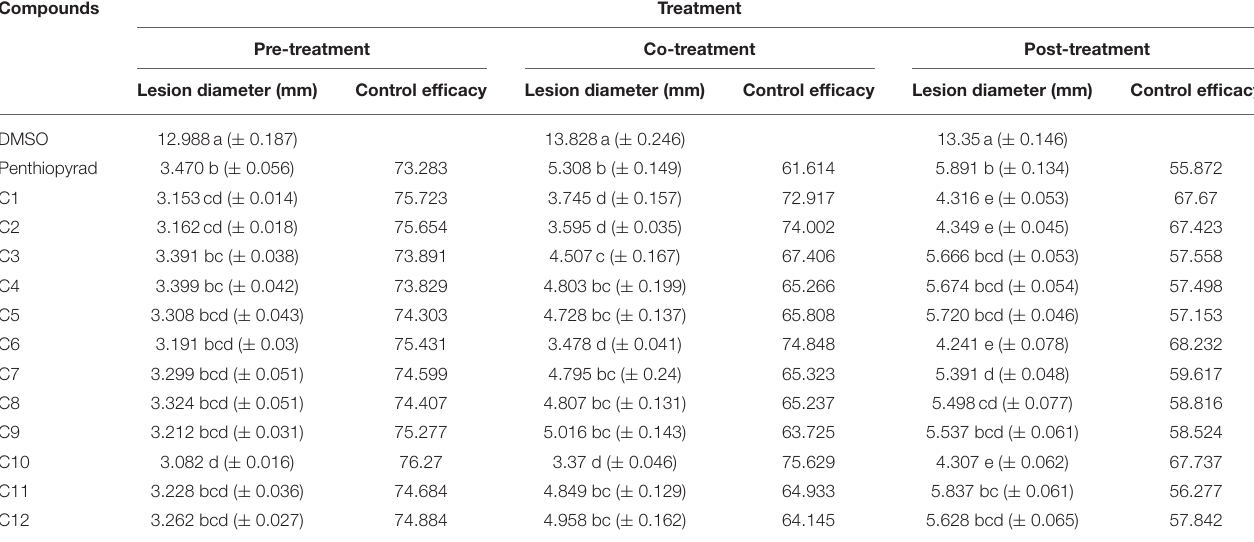
TABLE 4 | Comparison of lesion diameter and % disease (EB) control after treatment with SDHIs on potato tubers. Compounds